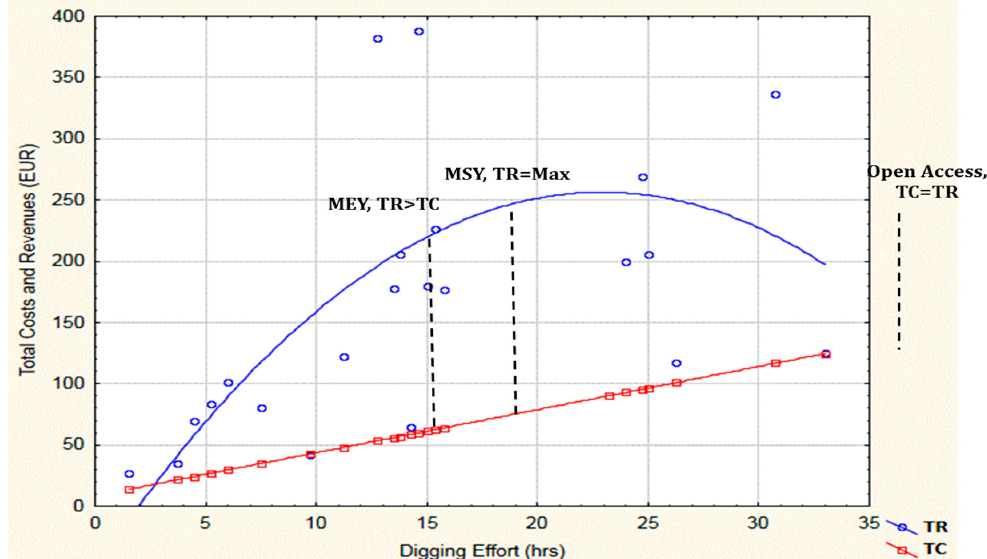
Figure 6. Total revenues and costs against digging effort in Aveiro lagoon for the surveying period 2012–2013. Note: TC = Total Costs; TR = Total Revenues; MEY = Maximum Economic Yield; MSY = Maximum Sustainable Yield; MC = Marginal Costs; MR = Marginal Revenues.